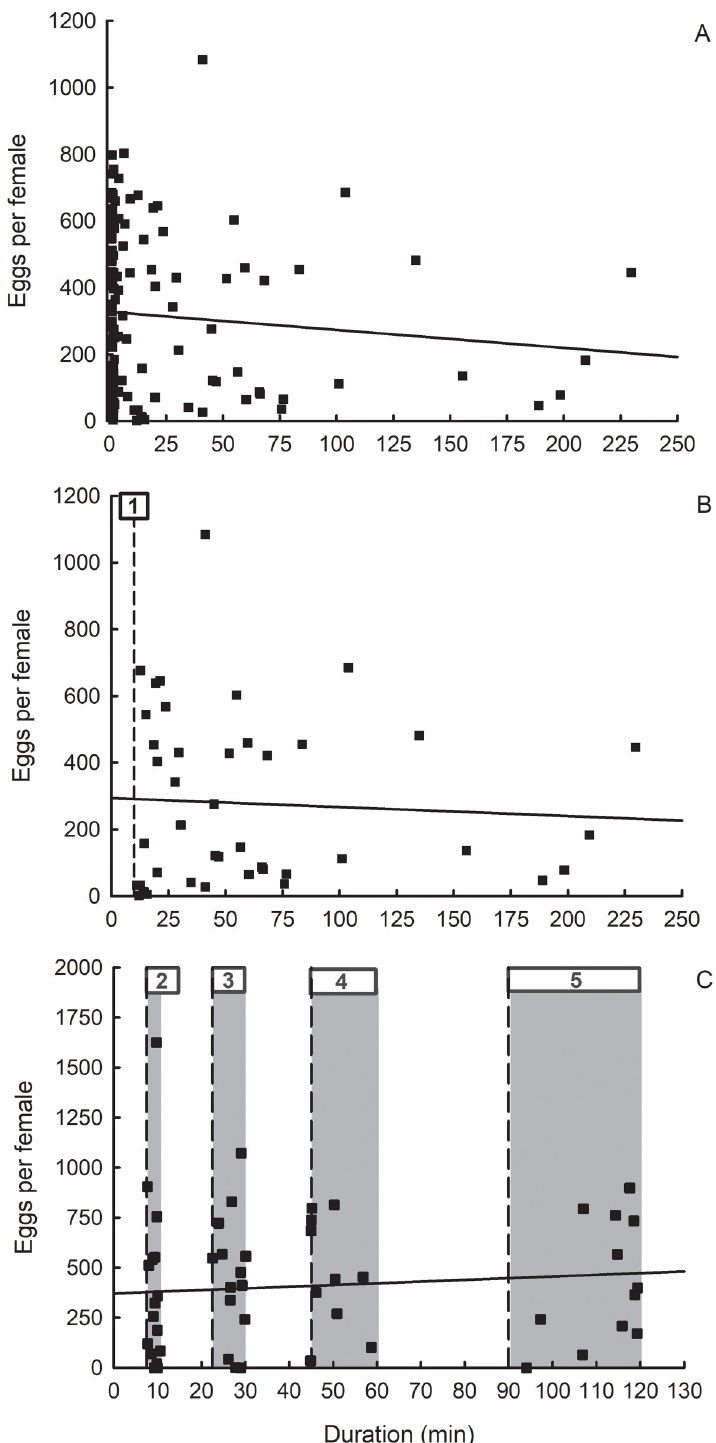
Fig 6. Influence of longest single flight duration on lifetime fecundity of western corn rootworm in (A, B) voluntary flight experiment, and (C) forced flight experiment. (A) Linear regression of eggs per female (Y) on the duration of the longest single flight (X): df = 1, 126, Y = -0.54X + 327.66, t = -1.08, P = 0.2835, r 2 = 0.0091. (B) (1) Dashed line at 10 min indicates separation between trivial fliers and sustained fliers. Linear regression of eggs per female (Y) on the duration of the longest single flight (X) for females that engaged in a single flight lasting � 10 min: